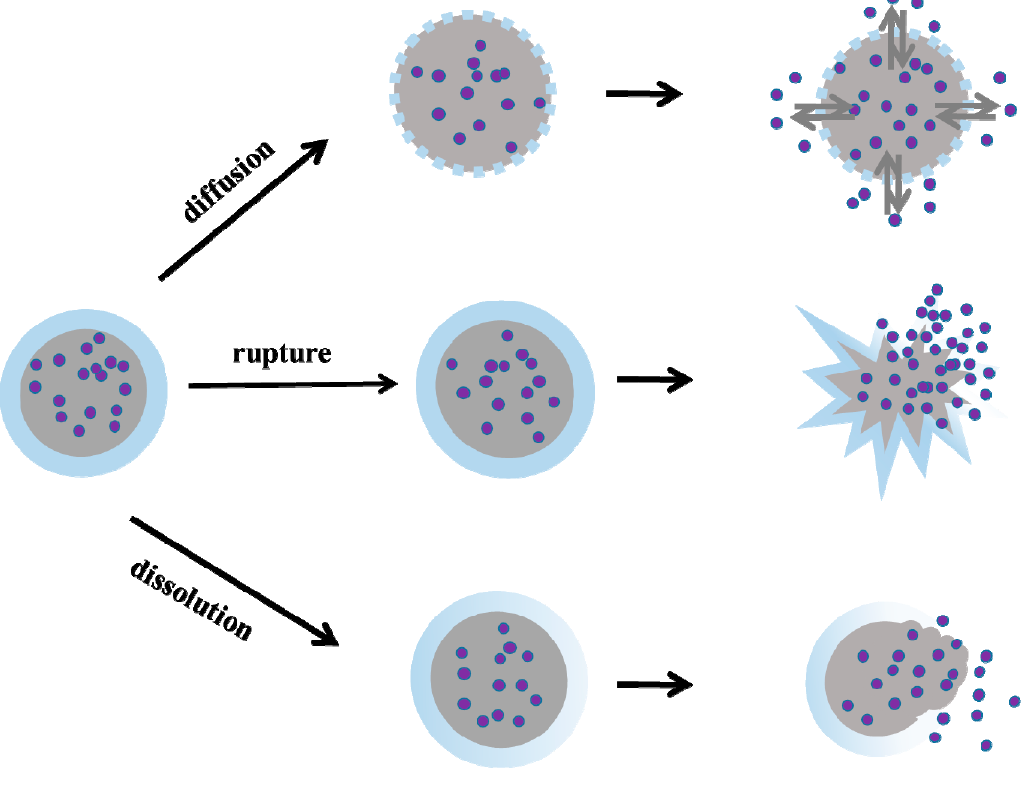
Figure 5. Release mechanism of the core material.